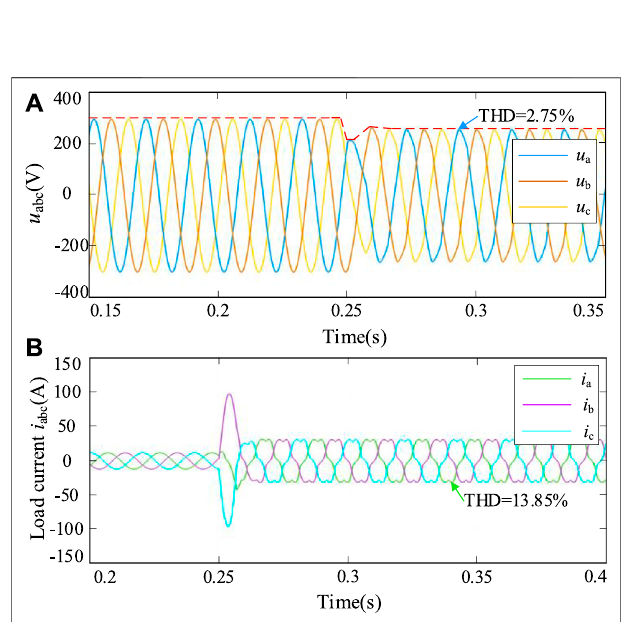
FIGURE12 | Output voltage (A) and current (B) ofthe inverter under the traditional control strategy (harmonic).